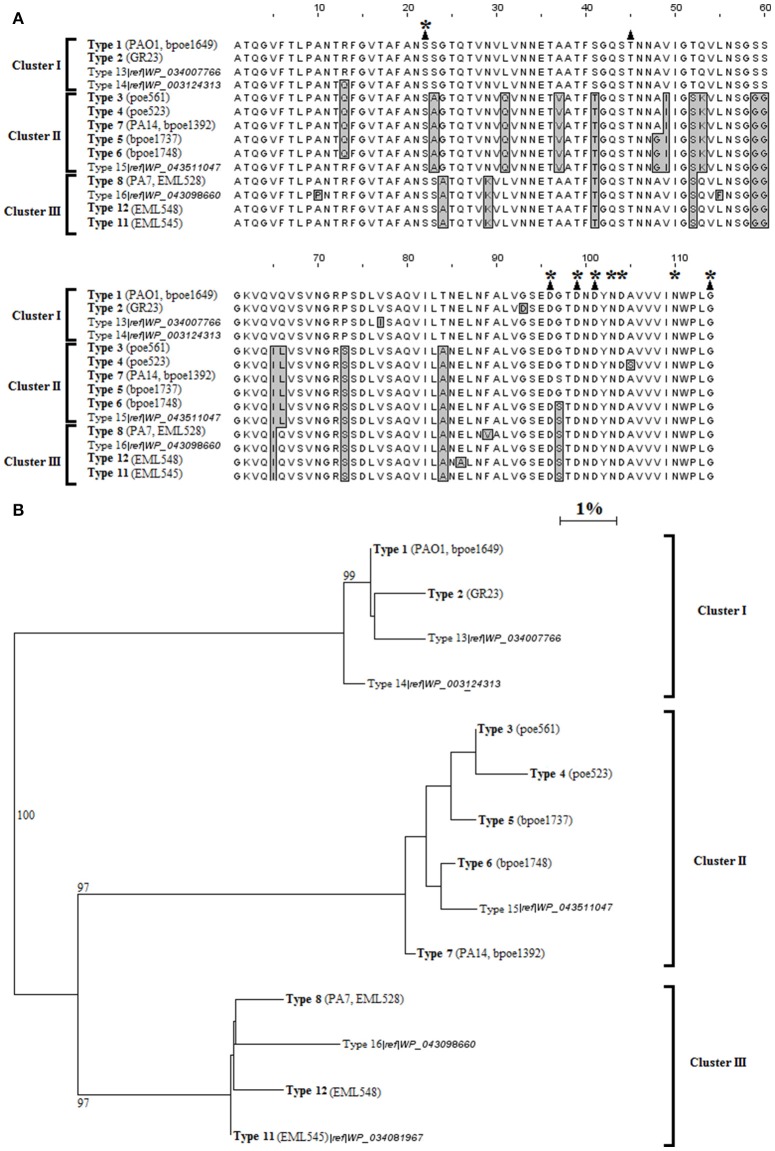
LecB types among P. aeruginosa. (A) Alignment of the 14 types of LecB amino acid sequences detected in this work (bold text) or recovered from the GenBank database (faint text). Amino acids different from those of the PAO1 sequence (total of 25 positions) are boxed and in gray. Black triangles indicate the amino acids participating in sugar binding, and asterisks the amino acids participating in calcium coordination. (B) Neighbor-Joining phylogenetic tree of the 14 LecB sequence types. One hundred and fourteen sites were analyzed. Horizontal lines represent the divergence % between pairs of sequences. Bootstrap values are indicated on branches. Representative strains of the 12 types identified in this work are indicated. Types 9 and 10 are not indicated but showed, respectively, a single change with type 1, and a single one with type 6.